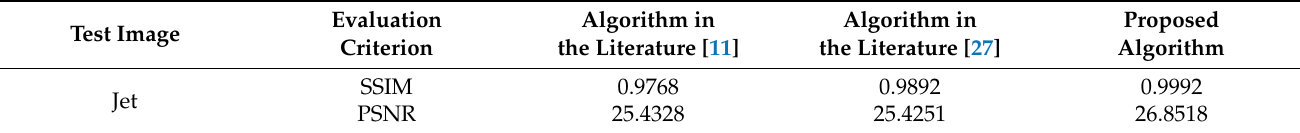
Table 5. Final result of simulation